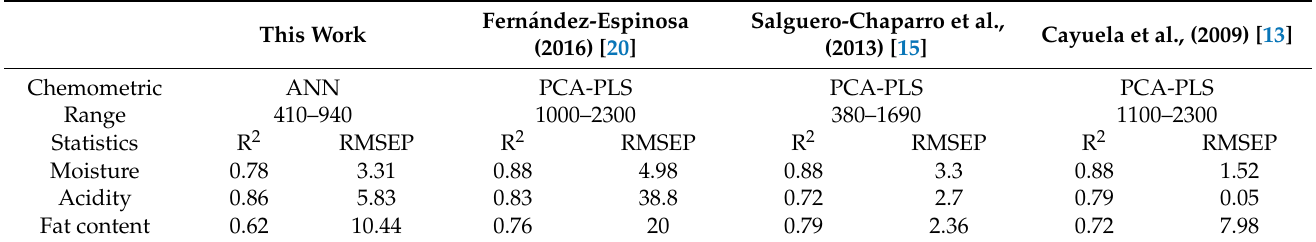
Table 4. Summary of articles addressing the estimation of olive fruit moisture, acidity, and fat content by means of spectral